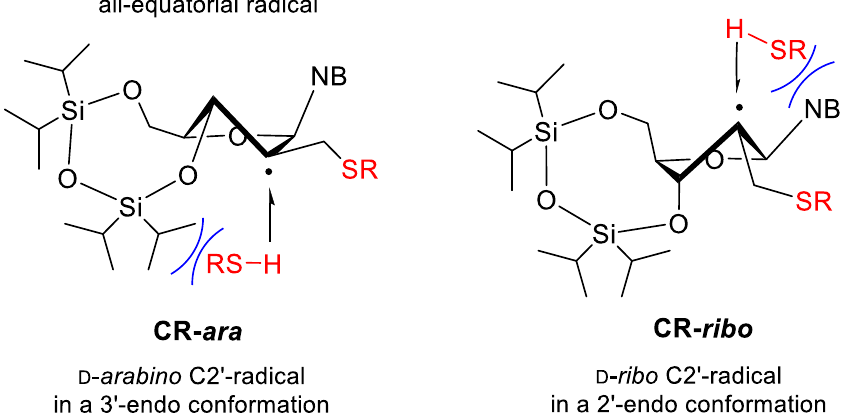
Figure 1. Structure of carbon-centered radical intermediates formed upon addition of thiyl radicals onto 2′ -exocyclic double bond of nucleosides and direction of H-abstraction by these radicals. The n -butylthiomethyl-substituted pyrimidine nucleoside 15 was desilylated with tetrabutyl ammonium fluoride (TBAF) to give 19 in 81% yield (Scheme 2.). As compound 19 did not show cytotoxic activity (vide infra), deprotection of further derivatives was not performed.